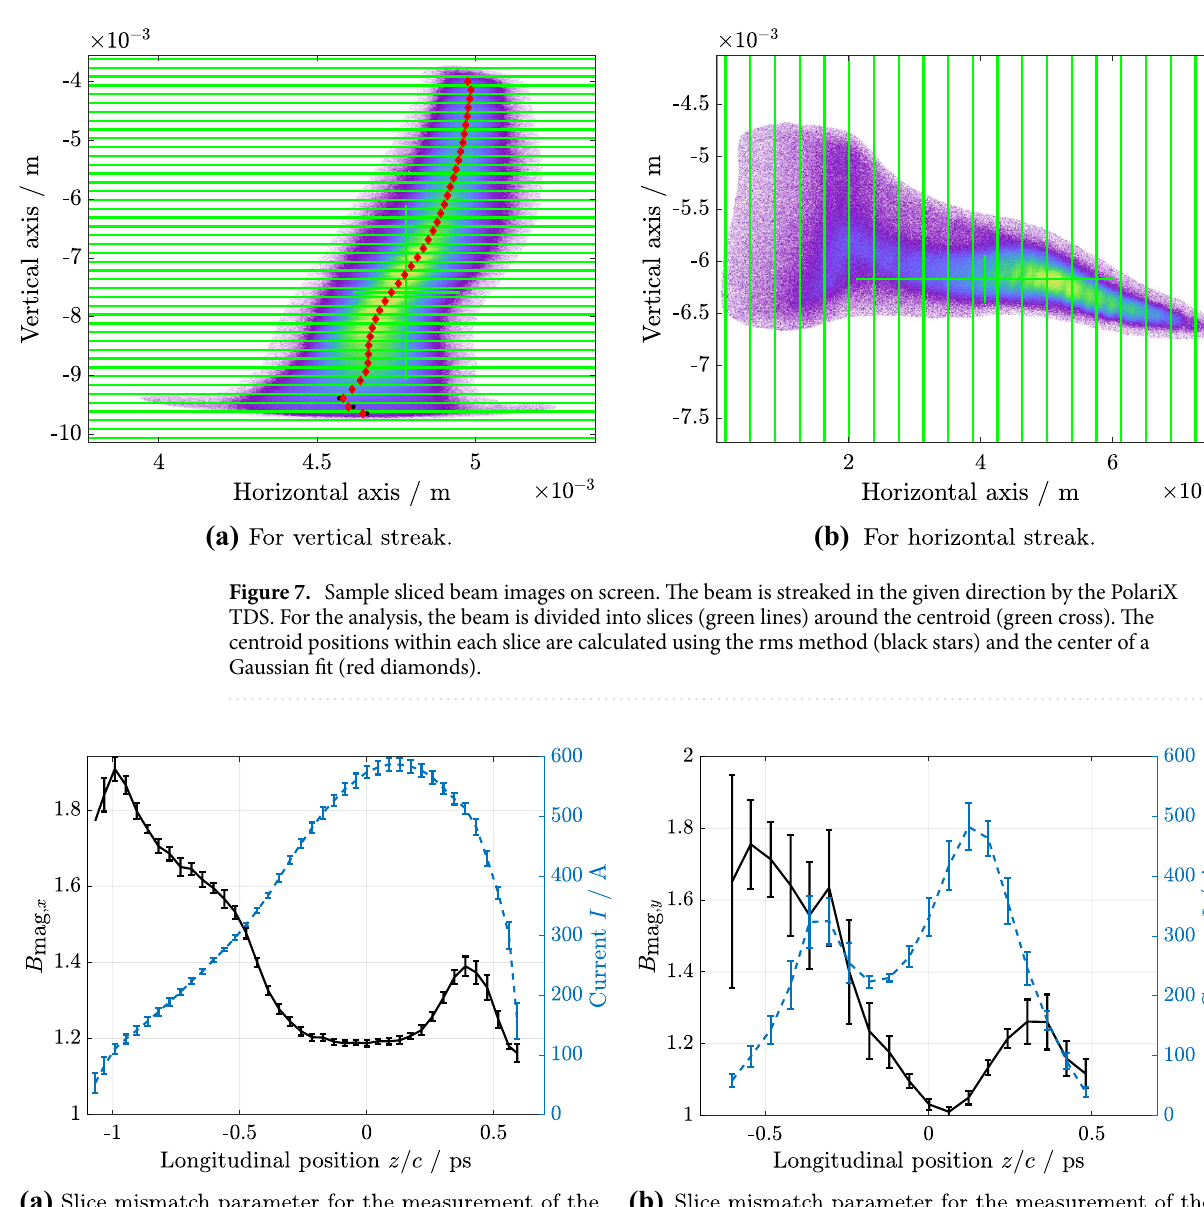
Figure 8. Slice mismatch parameters for the emittance